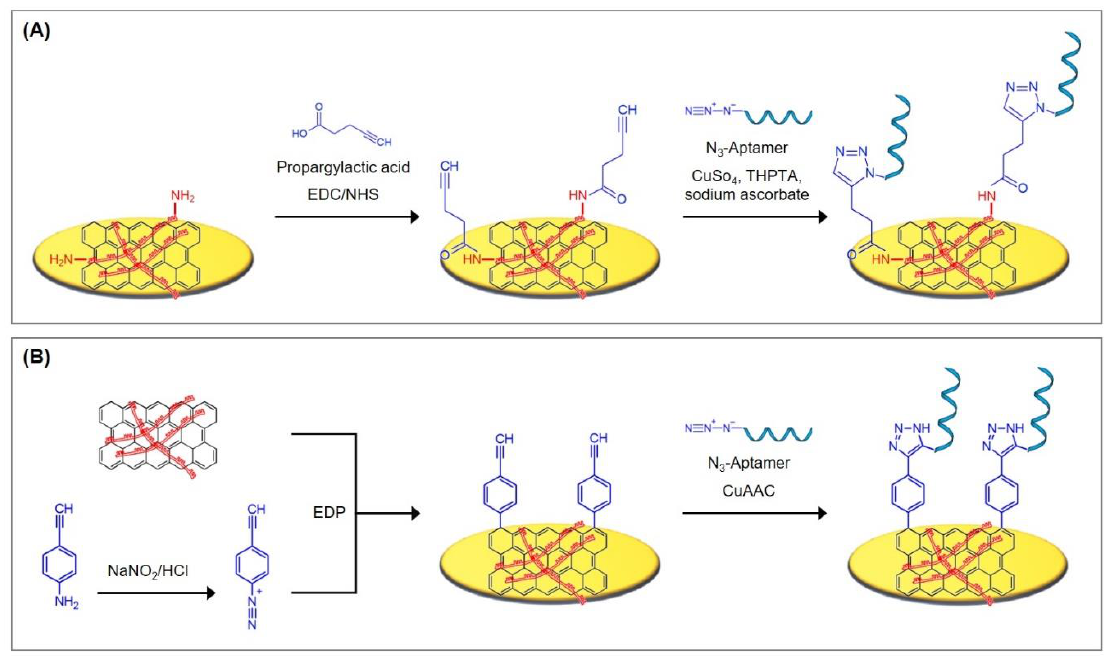
Figure 23. Various recently employed immobilization strategies based on the electrodeposition of graphene oxide in combination with PEI: ( A ) Immobilization of azide-terminated aptamers onto PEI [23]; ( B ) Immobilization of azide-terminated aptamers onto rGO [24].